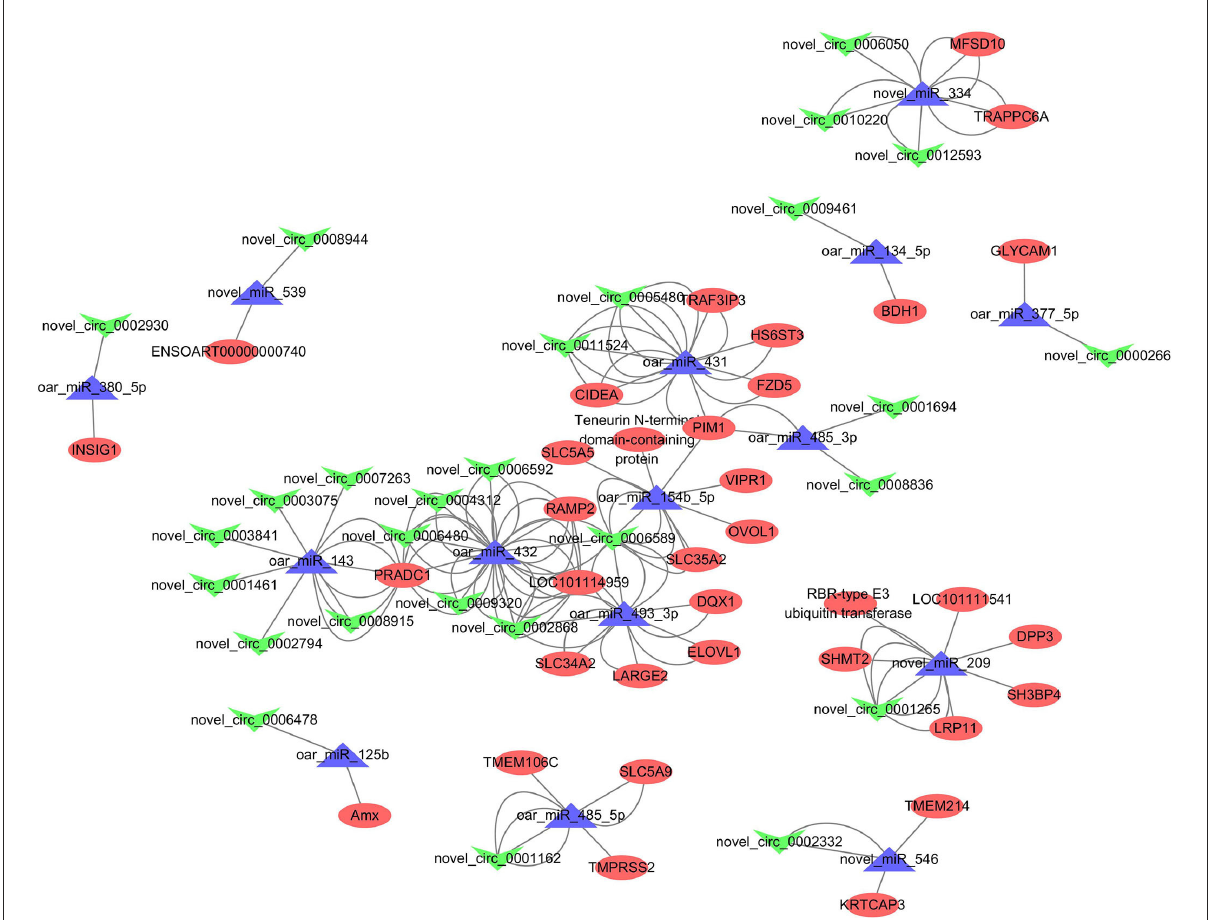
FIGURE9 Competing endogenous RNA (ceRNA) networks, in which the “V” shape (green), triangle (purple), and circle (red) represent circRNAs, miRNAs, and messenger RNAs (mRNAs),